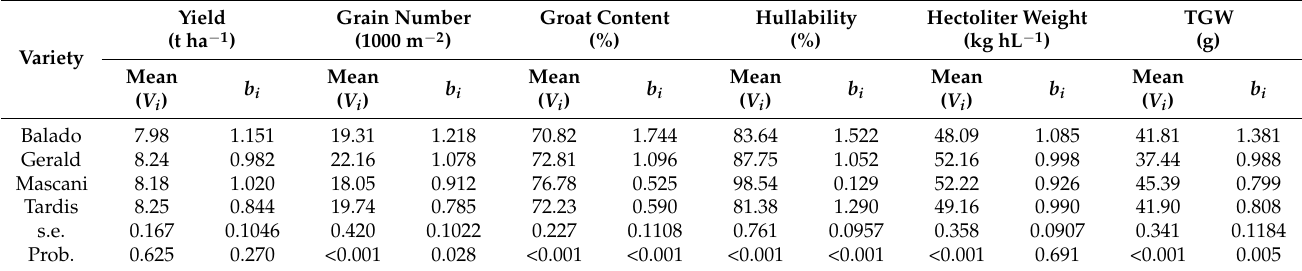
Table 3. Mean ( V i ) harvested grain yield (t ha − 1 ) grain quality and thousand grain weight (TGW) of four winter oat varieties grown in 22 environments and sensitivity ( b i ) to environment as determined by modified joint regression